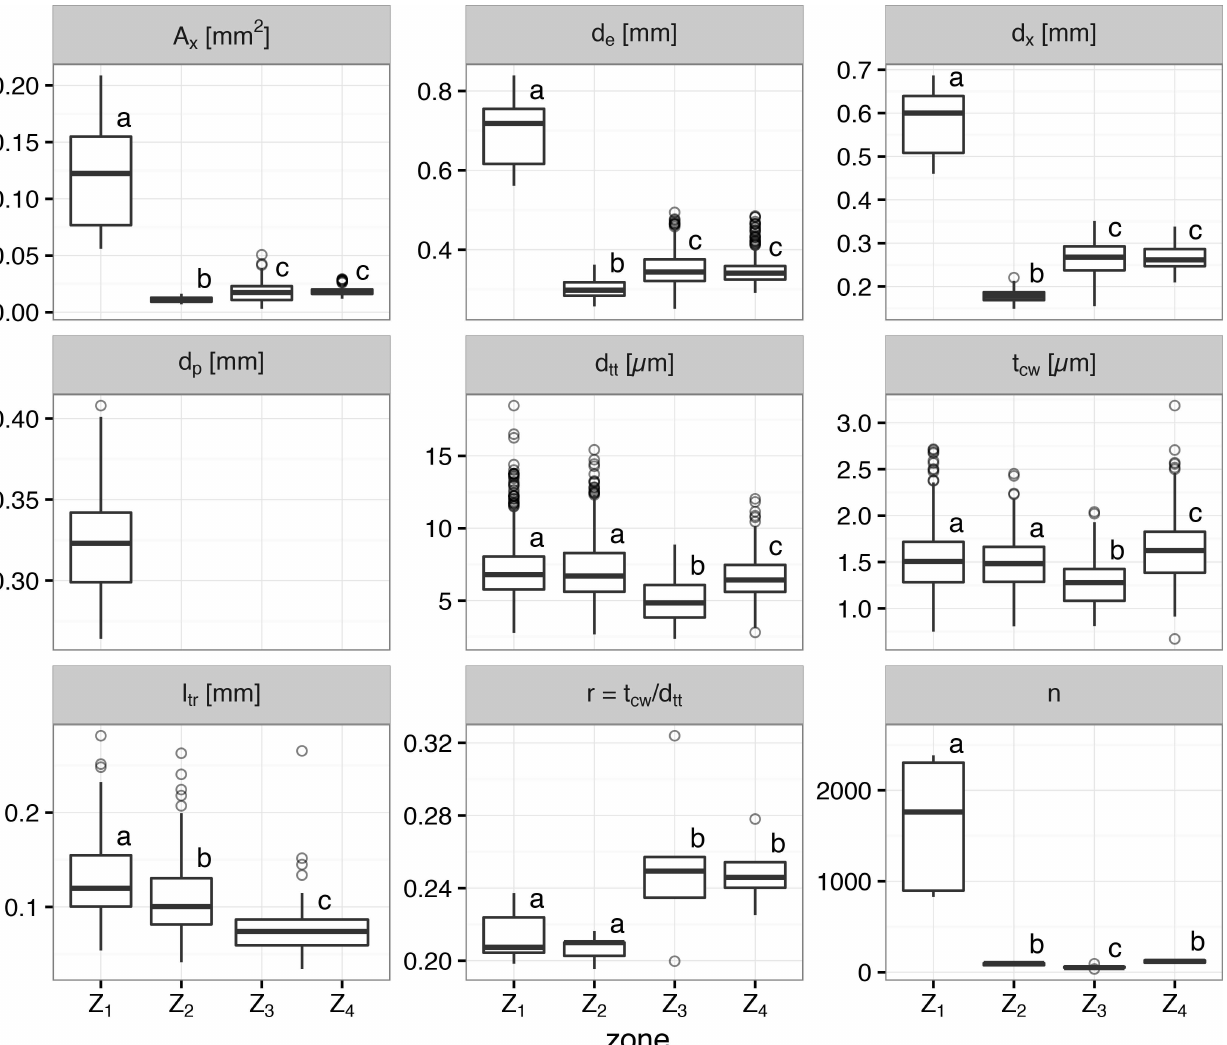
Fig 4. Anatomical parameters measured on cross and longitudinal sections of the vegetativeshoot(Z 1 ), the upperpartof the pedicel (Z 2 ), the transitionzone betweenthe vegetative shootand the pedicel(Z 3 ), and the basalpartof the pedicel(Z 4 ) in C . vulgaris (see Fig 1). Total xylem area in a cross section (A x ), externaldiameter(d e ), diameterof the vascular tissue(d x ), diameterof the pith tissue (d p ), diameter of conductingxylem units (dependingon zone: tracheaeand tracheidsor only tracheids; d tt ), cell wall thickness of conductingxylem units (t cw ), length of tracheids(l tr ), ratio of cell wall thickness to cell diameter(r = t cw /d tt ), and numberof vessels in a cross section (n),given in mean values ± SE. The box plots indicatethe median(= second quartile;line inside the box) and extend fromthe first to the third quartile. The whiskers show at most the 1.5 fold interquartilerange. Outliersare shown as black dots. Withina single parameter, lower case lettersindicate significantdifferences among the mean values of the four